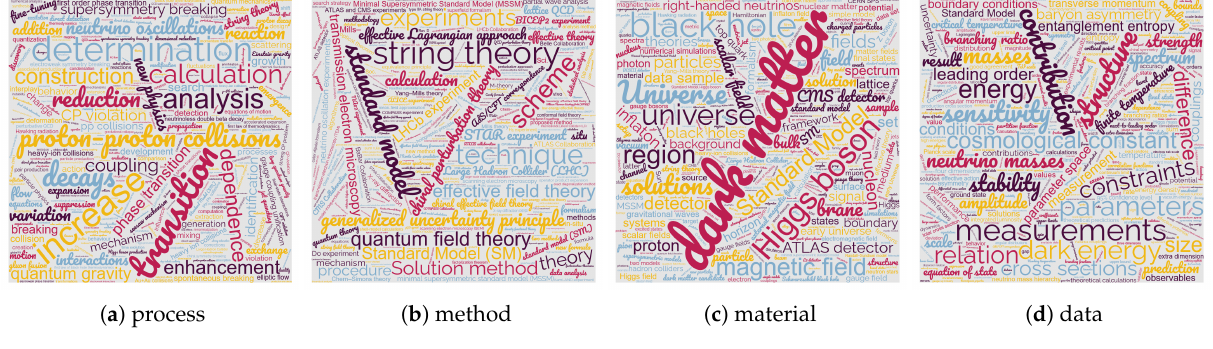
Figure 2. Astronomy domain word